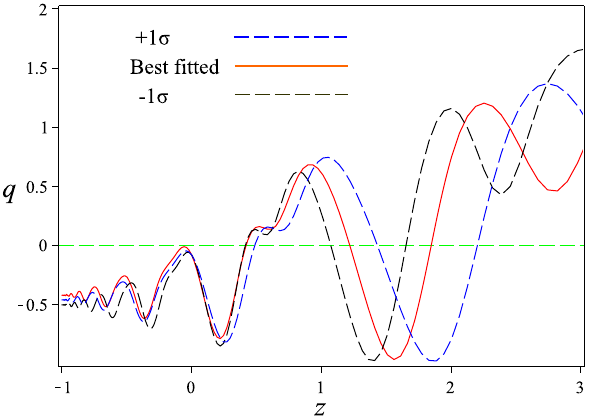
Fig. 3 The plot of deceleration parameters for the best-fitted values of (α,β) , (α = − 4 . 793 ,β = 6 . 92 ) and initial conditions